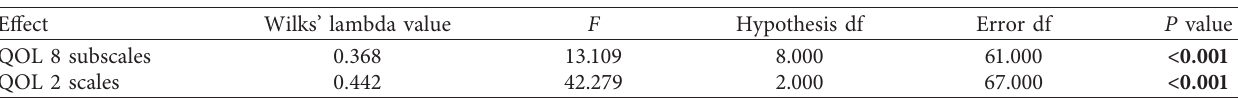
Table 4: Wilks’ Lambda multivariate tests for simultaneous comparing of subscales and scales between intervention and control groups.